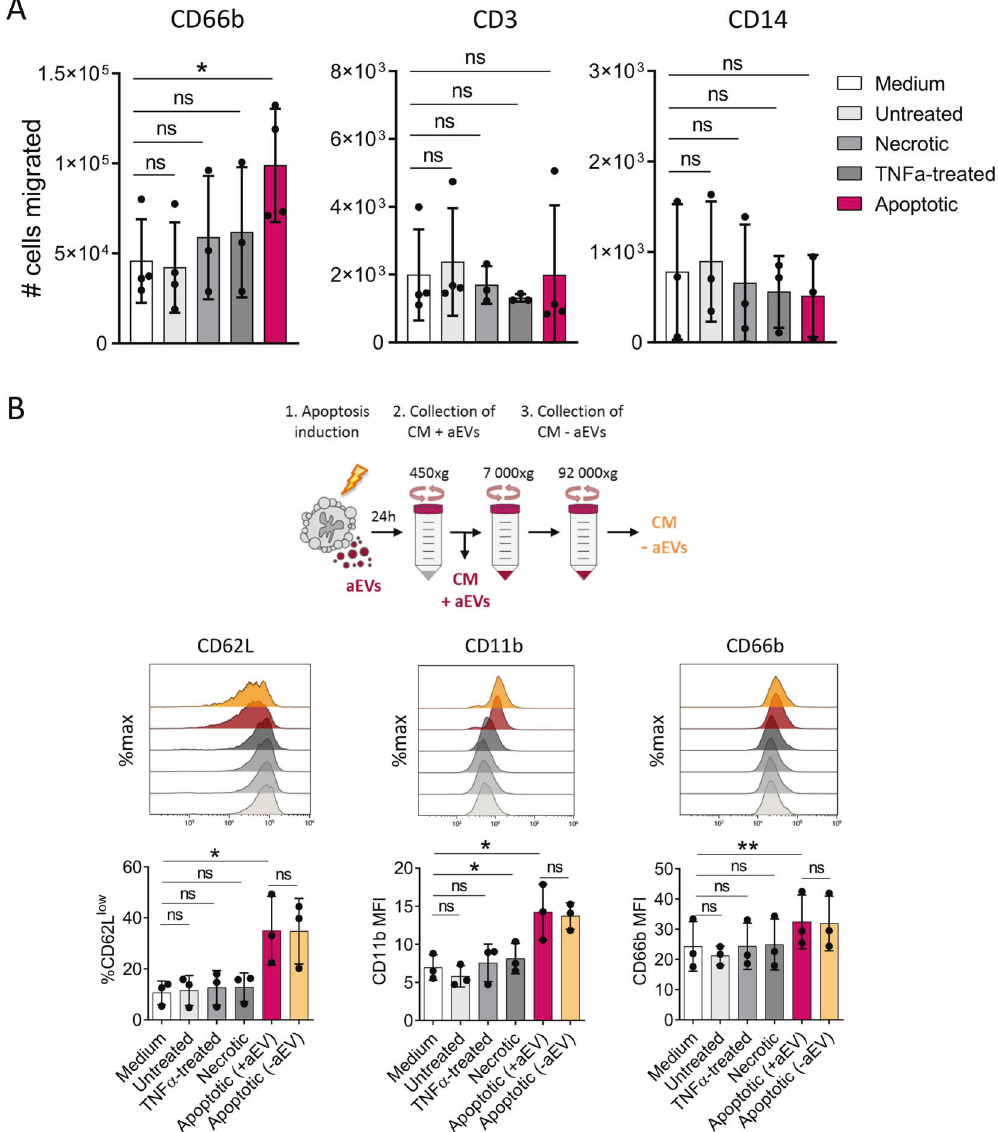
Fig. 1 Apoptotic-tumour cell-derived factors enhance neutrophil migration and phenotypic activation. A Transwell migration of healthy- donor derived white blood cells towards culture medium (negative control), conditioned media (CM) of untreated or apoptotic CG08 CRC cells. Flow cytometric quanti fi cation of migrated cells was performed after 2 h using counting beads ( n = 4). B Surface marker alterations of neutrophils isolated from healthy donors following stimulation for 2 h with CM of untreated, TNF α -treated, necrotic or apoptotic CG08 CRC cells, as analysed by fl ow cytometry ( n = 3). Where indicated, aEVs were depleted from apoptotic CG08 CM using sequential centrifugation steps at 450 × g , 7000 × g , and 92,000 × g (CM-aEVs). Graphs present mean ± SD. * P < 0.05, ** P < 0.01, ns not signi fi cant, as calculated by two- tailed paired t